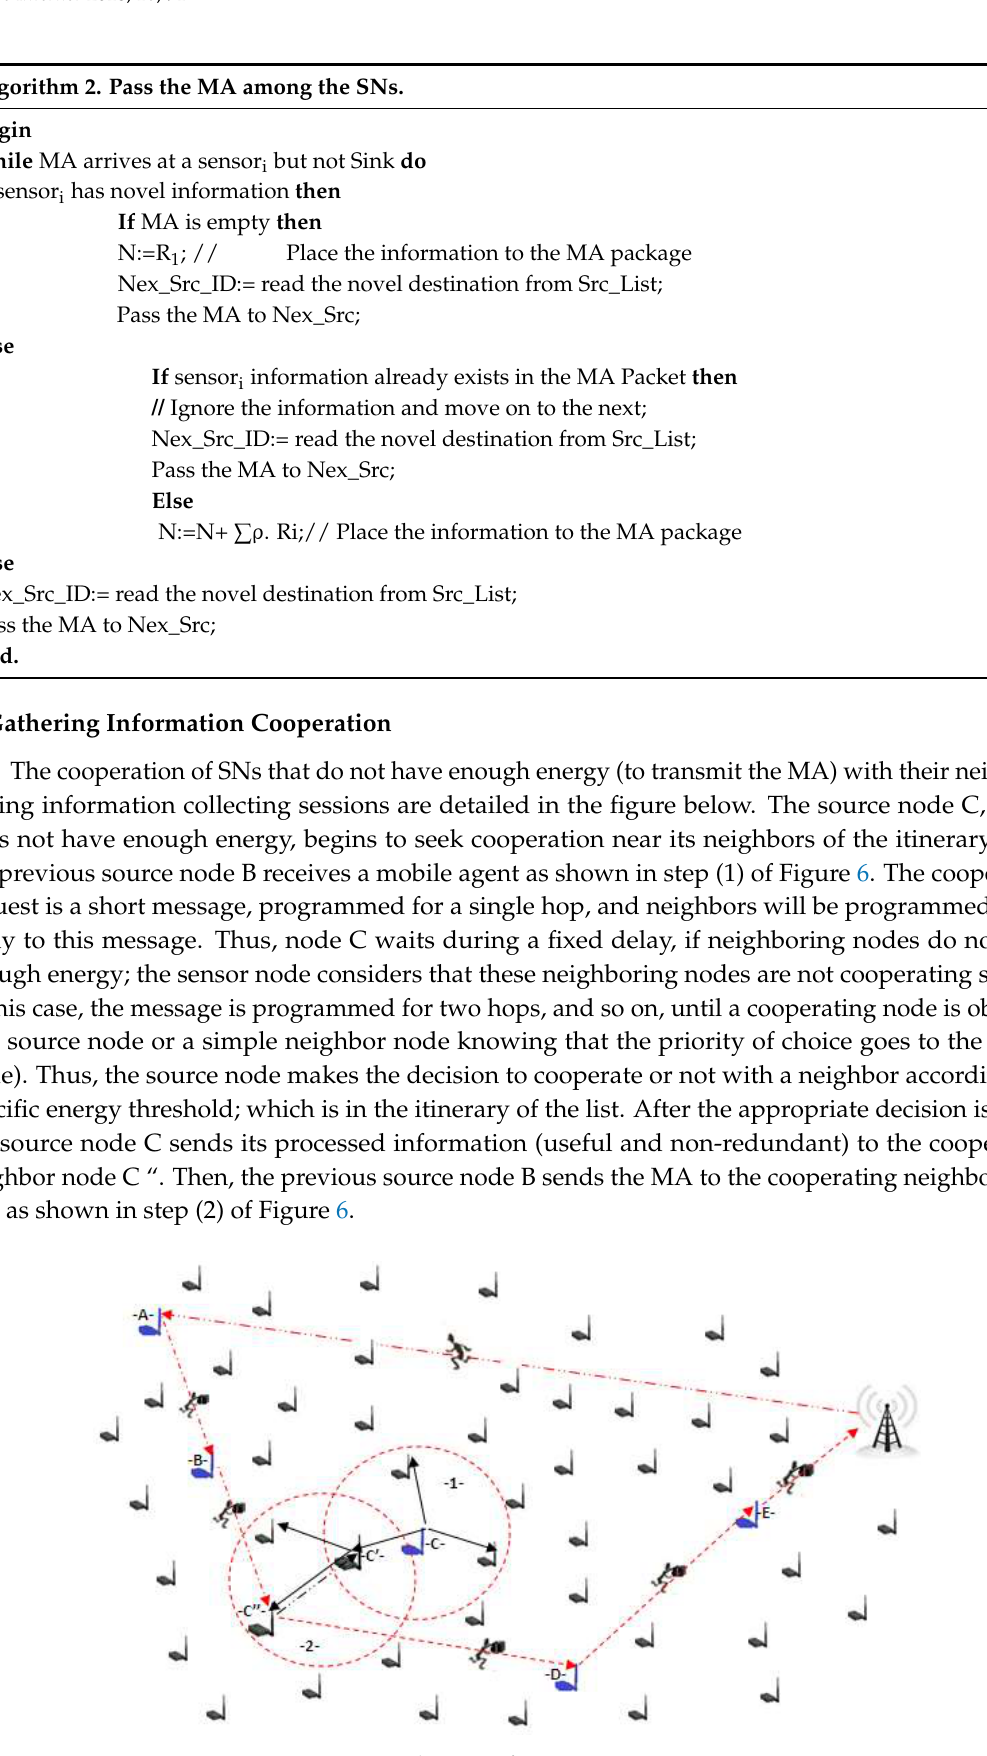
Figure 6. Gathering information cooperation. Algorithm 3. Pass the MA among the SNs.